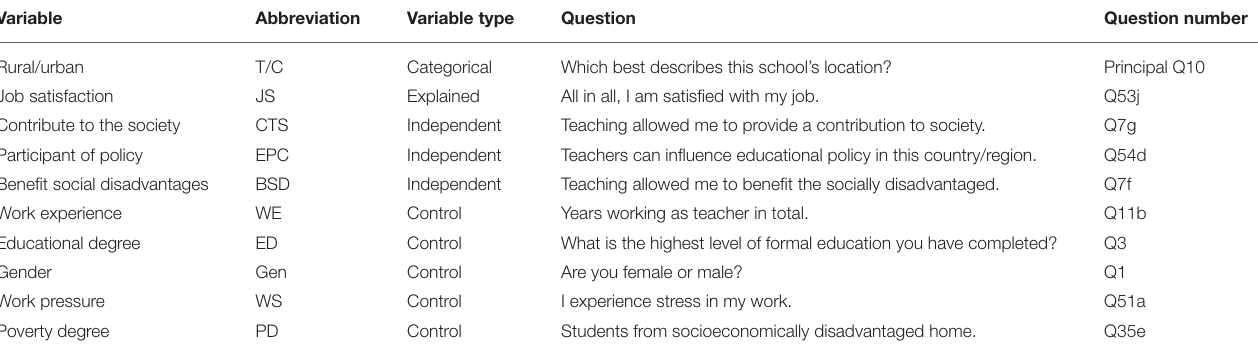
TABLE 1 | Variables and